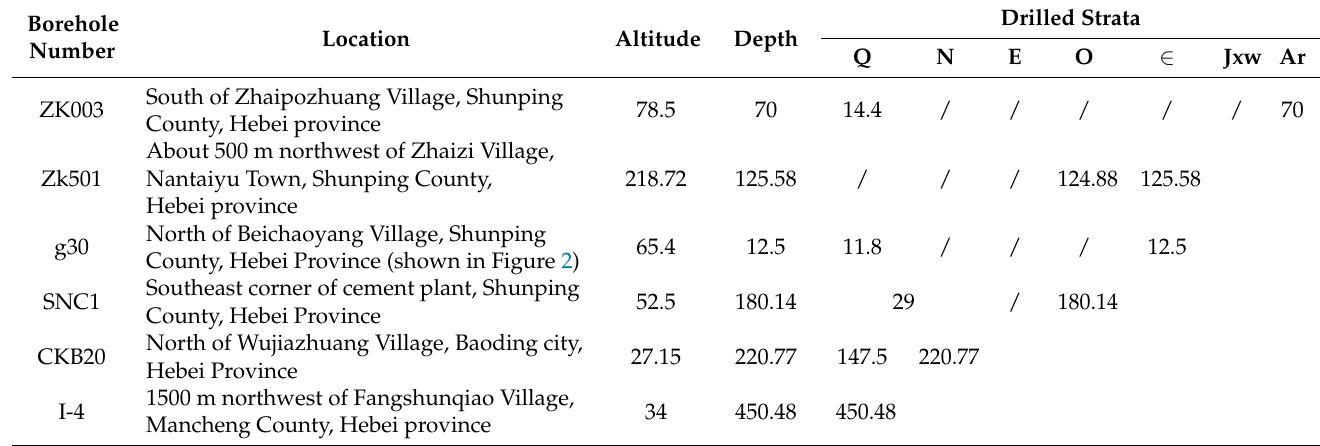
Table 1. Formations encountered by drilling within the research